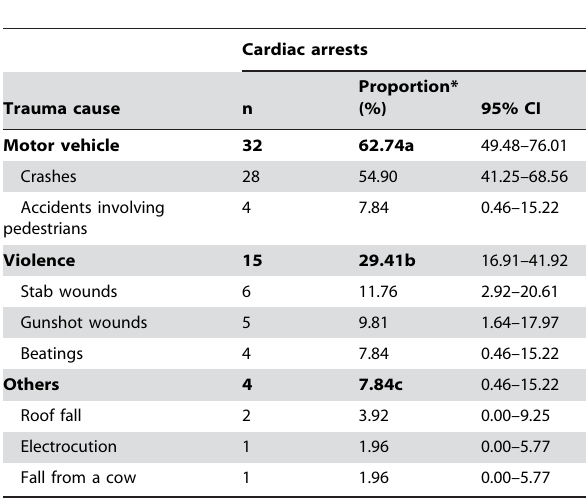
Table 4. Intraoperative cardiac arrest proportions, grouped by trauma cause.